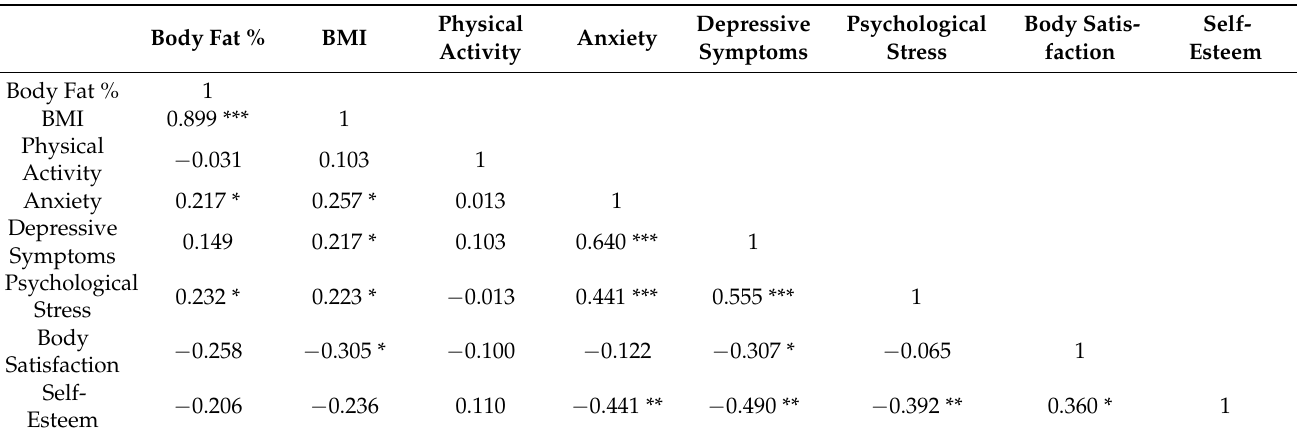
Table 4. Pearson correlations between body composition, physical activity, mental health, body satisfaction, and self-esteem for males.